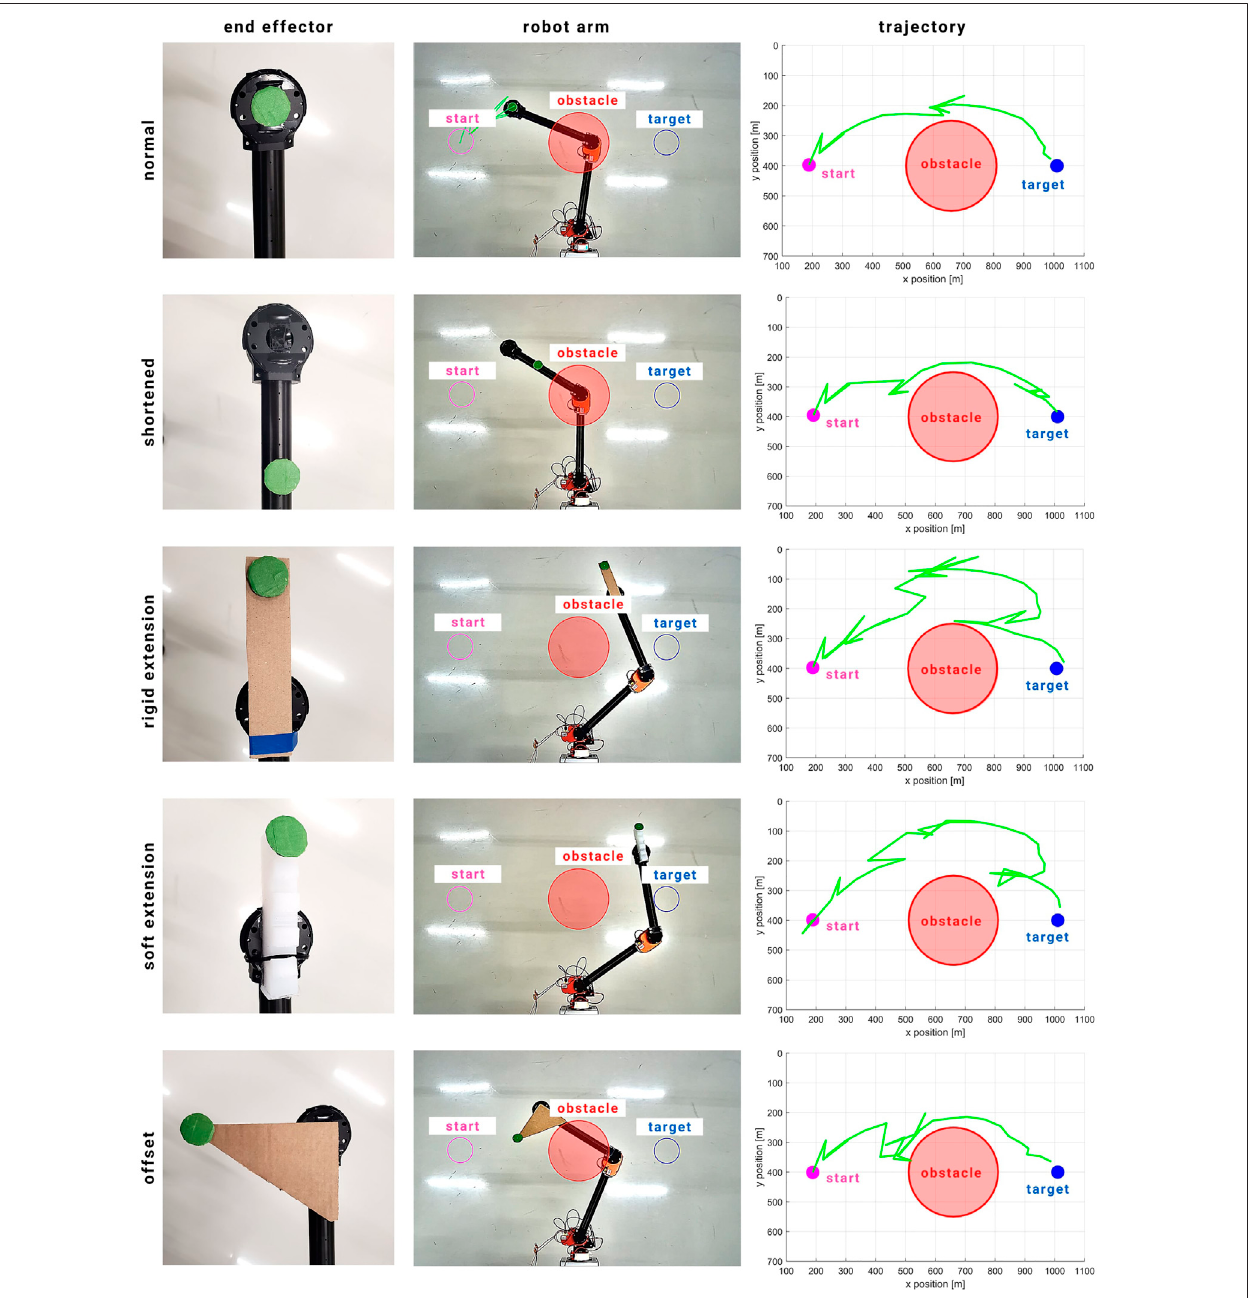
FIGURE5| Physicalexperimentresultsofreachingandobstacleavoidancewhilstmodifyingtheendeffectorduringexecution.Whentheendeffectorisaltered,the controller triggers an exploration phase and resumes reaching and obstacle avoidance right after. The modi fi cations include shortening the end effector, rigid and soft extensions, and offsetting the end